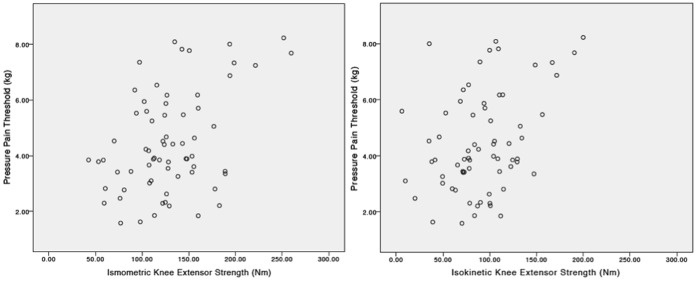
Knee Extensor Strength and Pressure Pain Threshold.This diagram demonstrates the associations between isometric knee extensor strength, isokinetic knee extensor strength and pressure pain threshold.